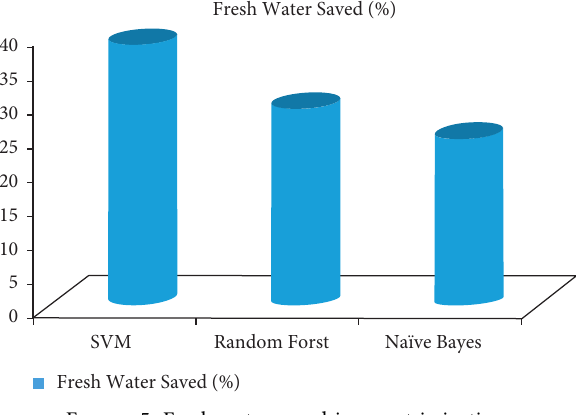
Figure 5: Fresh water saved in smart